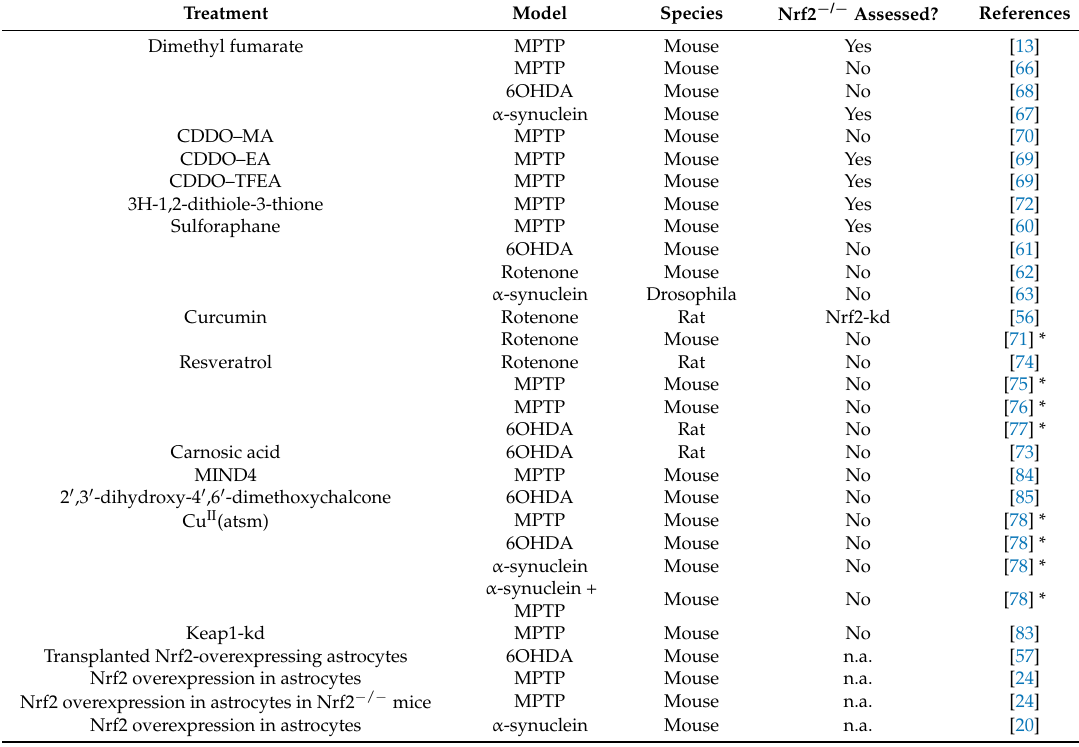
Table 1. Preclinical studies on Nrf2 activation in animal models of Parkinson’s disease.